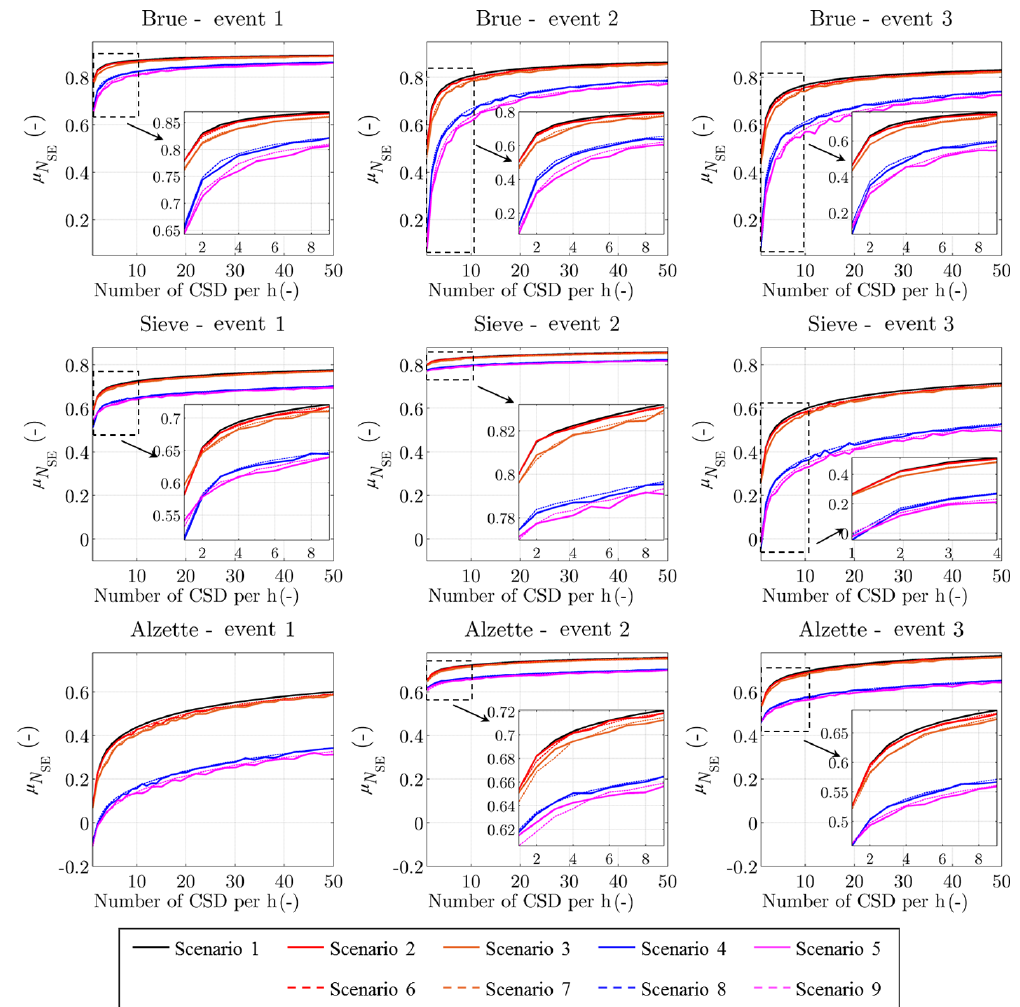
Figure 9. Dependency of the mean of the Nash–Sutcliffe efficiency sample, µ N experimental scenarios 1 to 9 for the considered flood events in the three catchments: Brue (upper row), Sieve (middle row), and Alzette (bottom row).